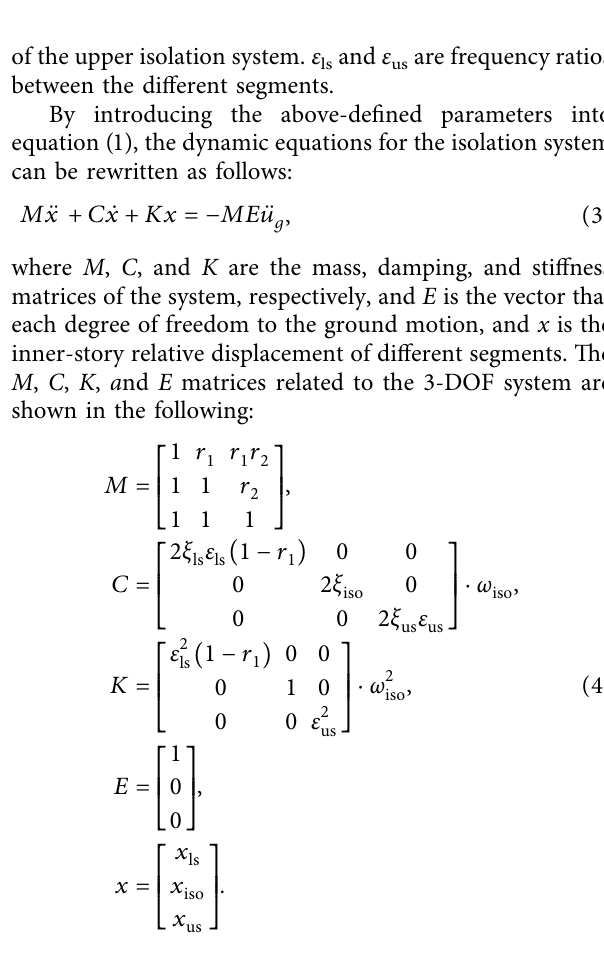
Figure 1: Simplified models for structures with the MSI system and its segment models: (a) 3-DOF model, (b) S-DOF model, and (c) 2-DOF